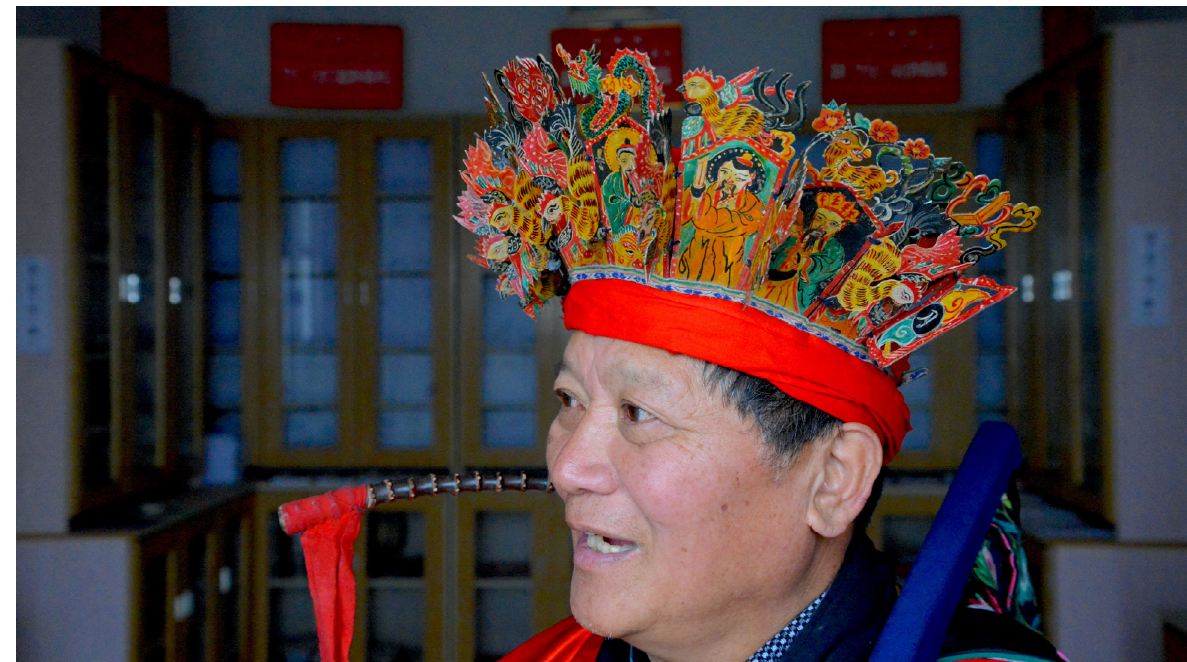
Figure 2. Badai Shi Shougui, wearing a san qing fa guan with twelve Daoist and Buddhist gods depicted, marking his status as a master badai. (Photo: Thomas Riccio).